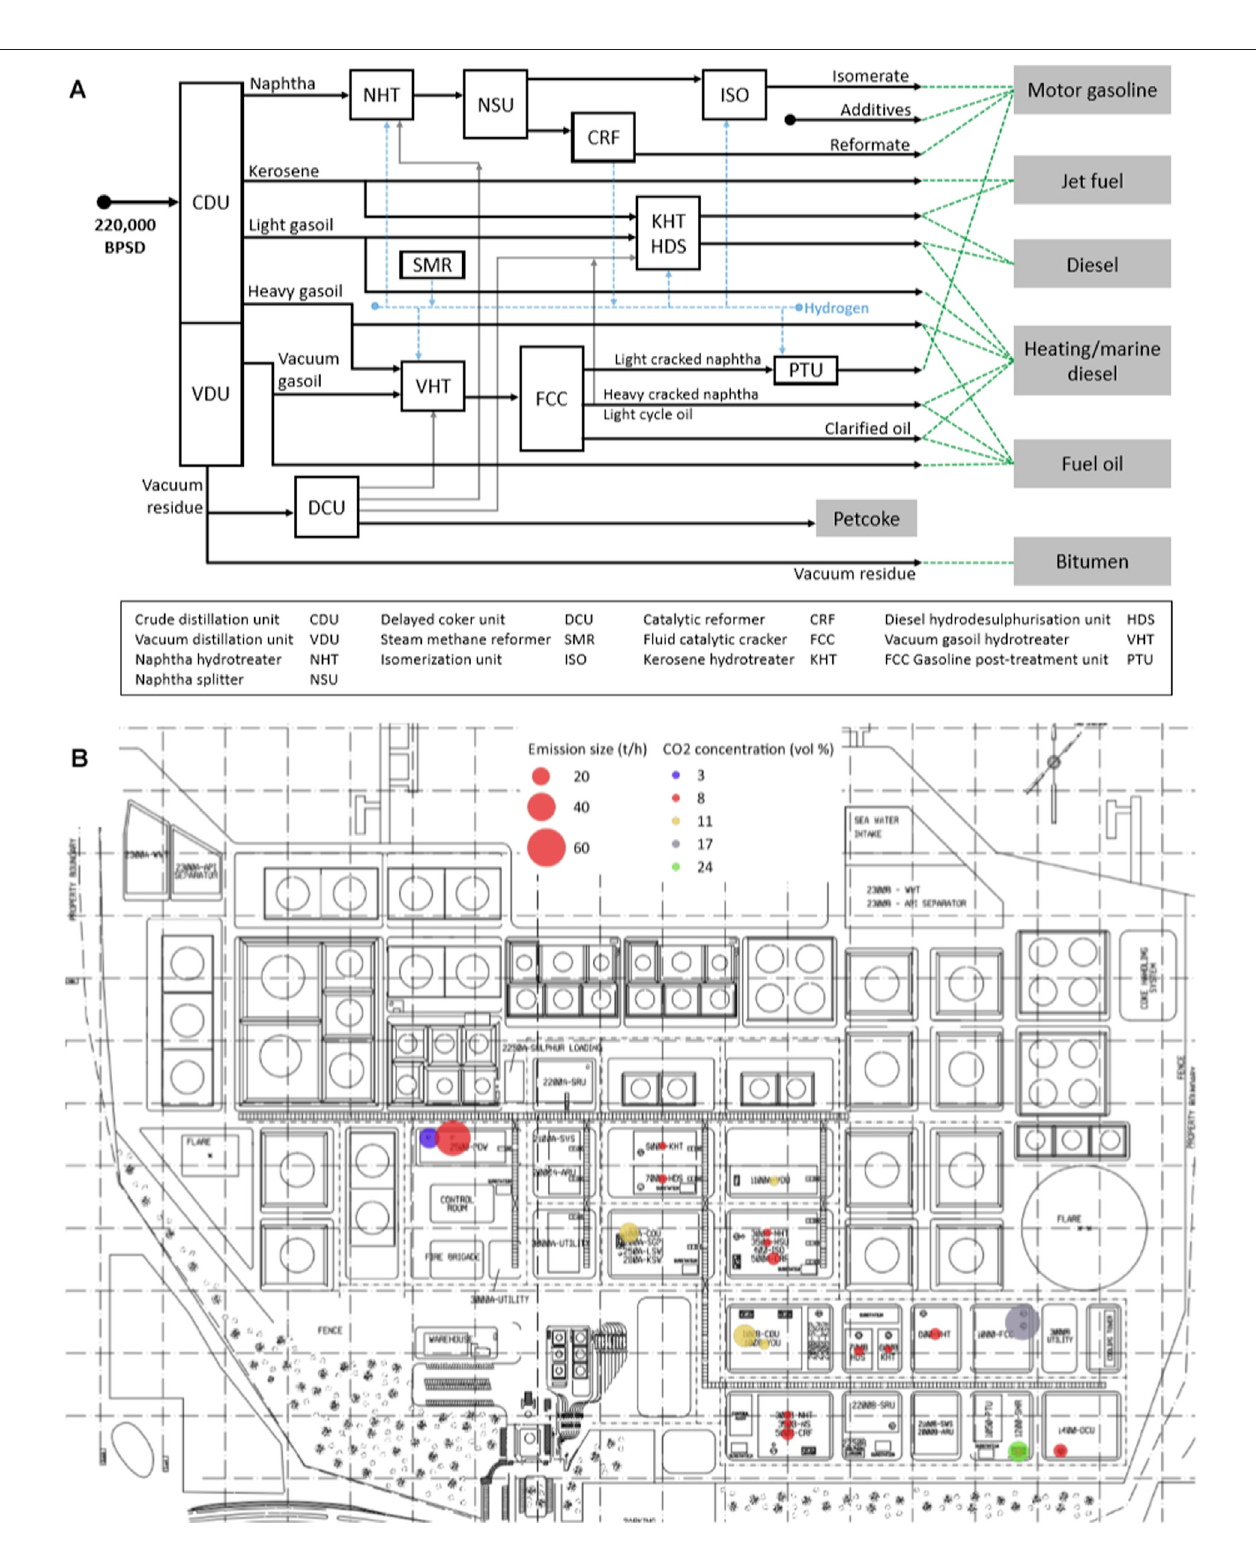
FIGURE 1 | Simpli fi ed re fi nery block fl ow diagram (A) , and example re fi nery plan (B) adapted from case 3 in IEAGHG (2017). The emission point sources in the re fi nery are overlaid in (B) to illustrate the distributed nature of these emissions.